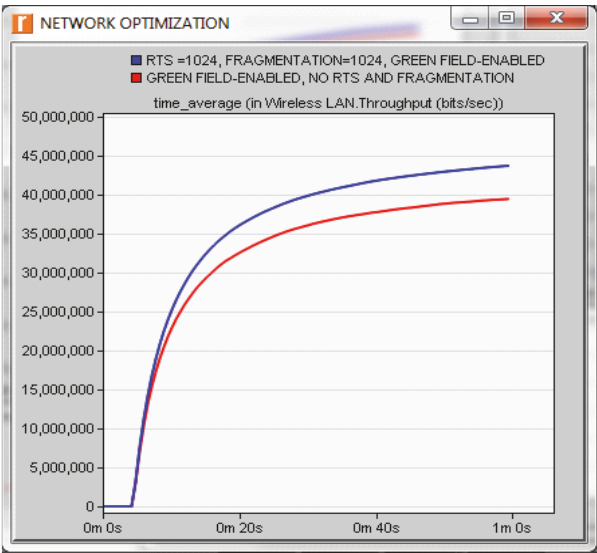
Figure 29: WLAN throughput optimization with RTS, fragmenta- tion, and Greenfield operation